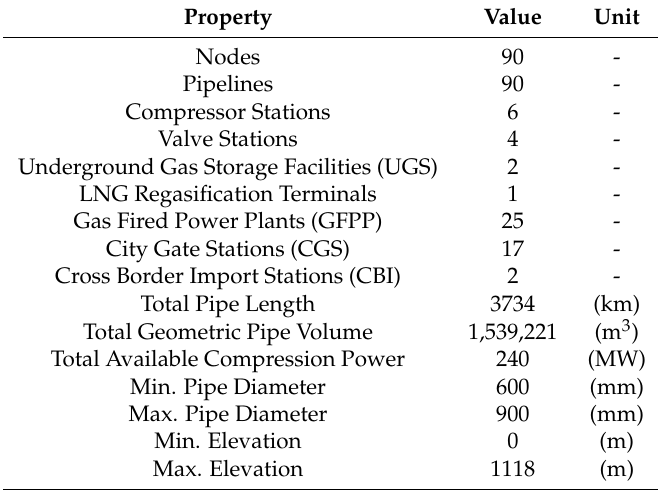
Figure 2. Topology of the GNET90 gas network. Labels with a red frame are pointing to gas fired power plant (GFPP), labels with a green frame indicate supply nodes, and those with a purple frame underground gas storage (UGS) facilities. Table 2. Properties of the GNET90 gas